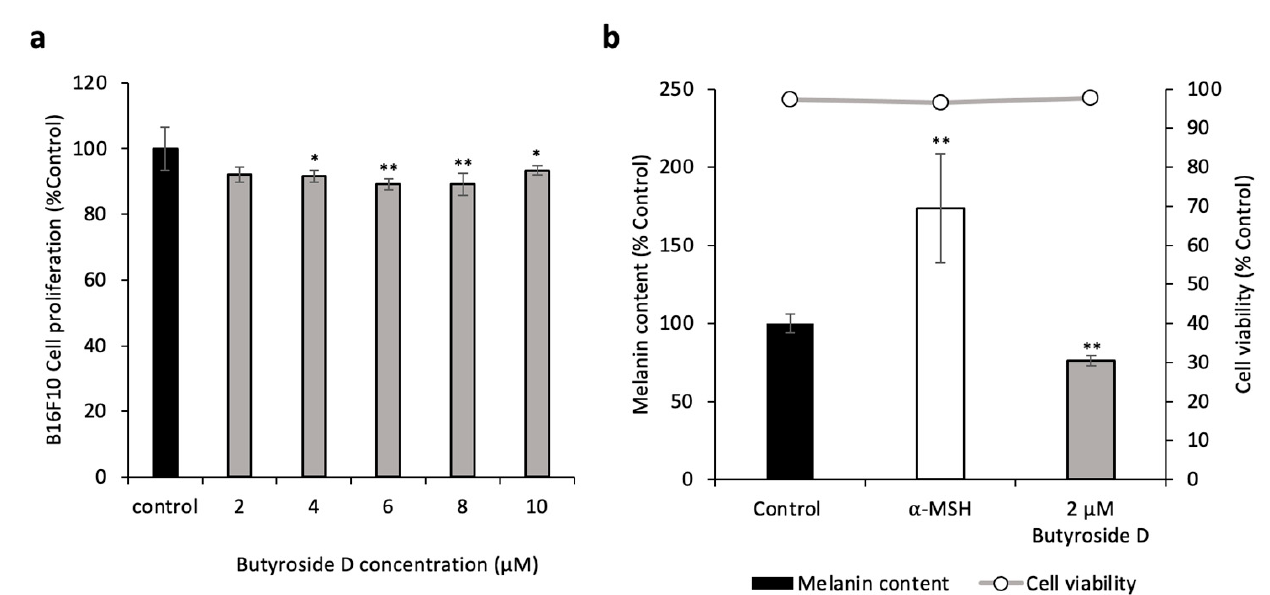
Figure 2. Butryoside D has no cytotoxic effect in B16F10 and inhibit melanin production in B16F10 cells. ( a ) MTT assay was performed to assess the cell proliferation of Butryoside D-treated B16F10 cells varying concentration (2, 4, 6, 8, and 10 µ M). ( b ) The intracellular melanin content of B16F10 cells were assessed. B16F10 cells were treated with 2 μ M Butryoside D or α -MSH as positive control, for 48 h. Results are presented as mean ± SD ( n = 3). Statistical analysis was performed using one- way ANOVA where asterisks denote significant differences between the control and test groups being * p < 0.05 and ** p < 0.01.